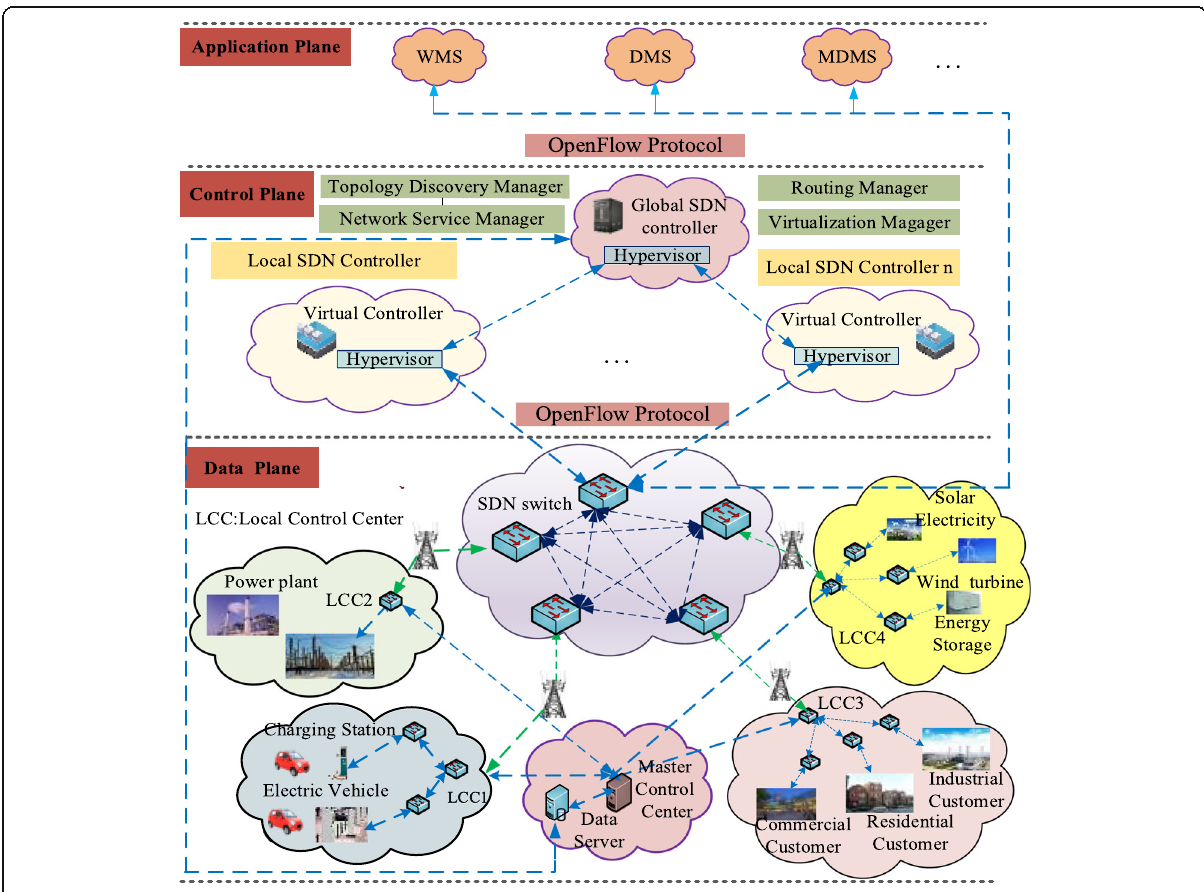
Fig. 1 Communication Architecture of Smart Grid based on